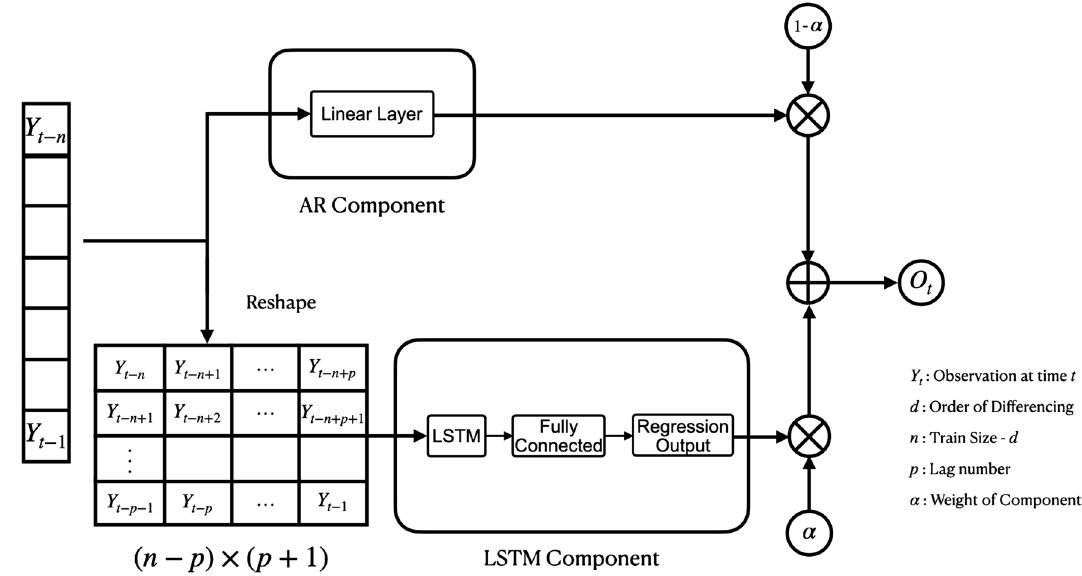
Figure 2. Visualization of the hybrid